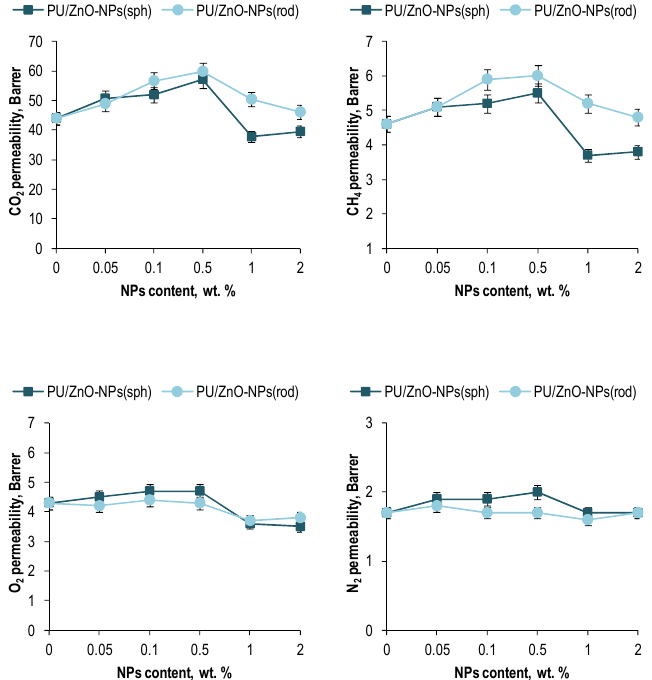
Figure 6. The permeability coefficients for the polymeric membranes based on the PU/ZnO-NPs. In addition to the affinity of the gases to the membrane filler, the difference in the kinetic diameters of the gas molecules could also made a contribution (Table